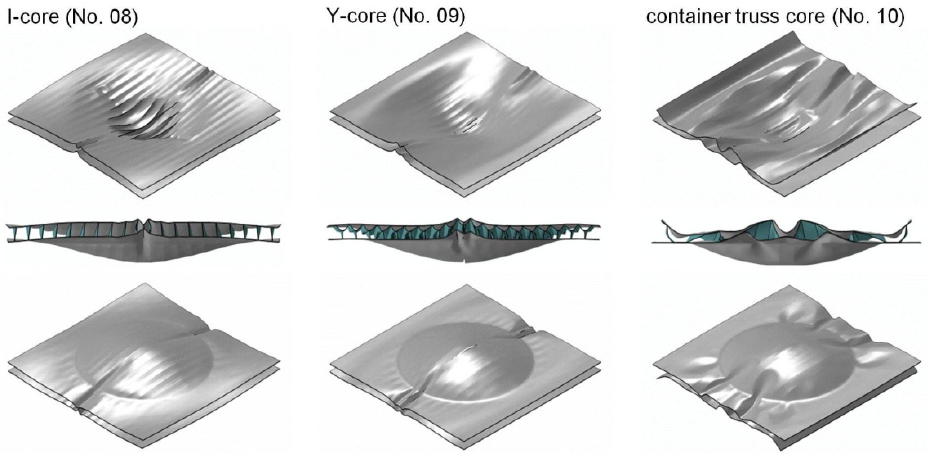
Figure A3. Deformation states of the top and bottom sides for prismatic, one-layered, non-auxetic cores No. 08–10 subjected to air-blast loading (t = 0.6 ms).